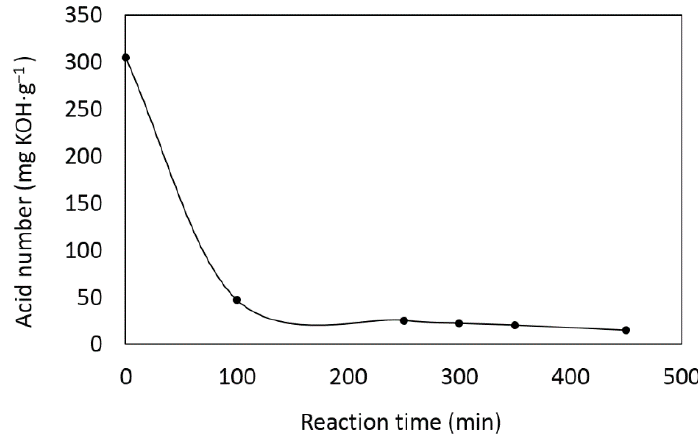
Figure 1. Acid number change vs. reaction time.